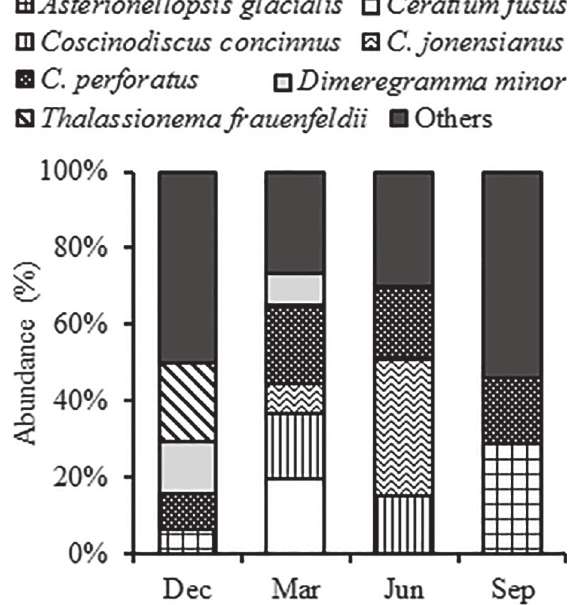
Figure 5 - Relative abundance of the main microphytoplankton species identified at Ajuruteua beach, Bragança, Pará.